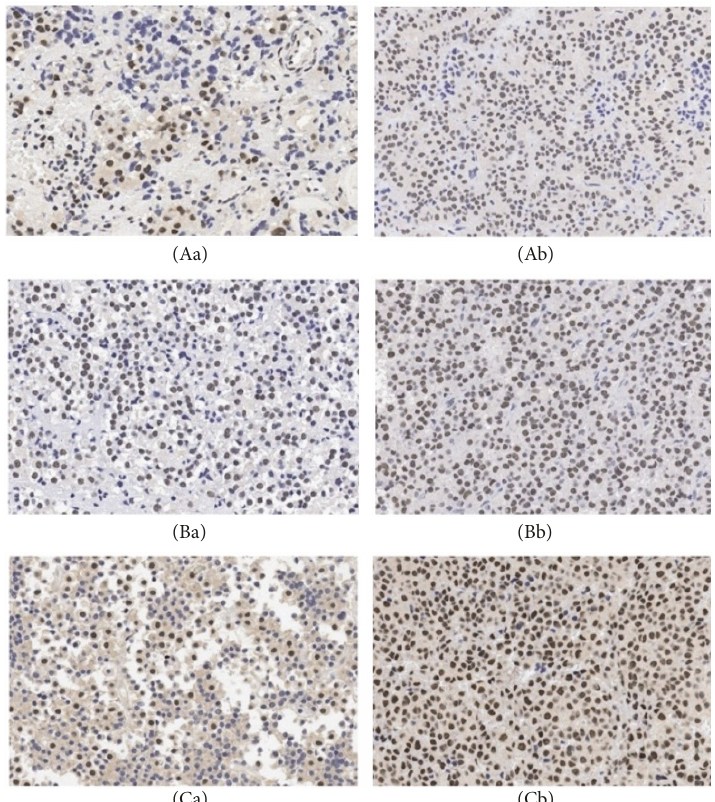
Figure 1: NR2C2 expressed in each group. (Aa): lowly expressed in noninvasive group; (Ab): highly expressed in invasive group; (Ba): lowly expressed in nonrecurrent group; (Bb): highly expressed in primary recurrent group; (Ca): lowly expressed in primary group; (Cb): highly expressed in recurrent group.